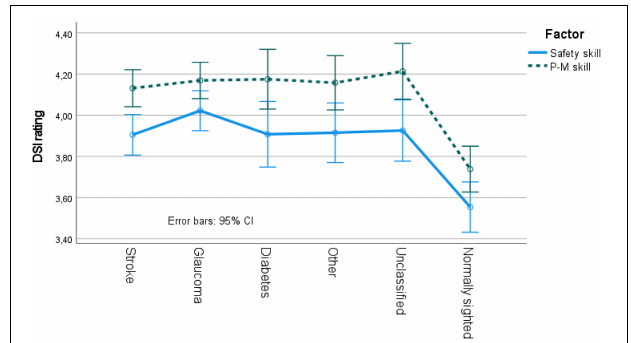
FIGURE 2 | DSI ratings for VFL and normally sighted participants. P-M skill, perceptual-motor skill; CI, confidence interval.